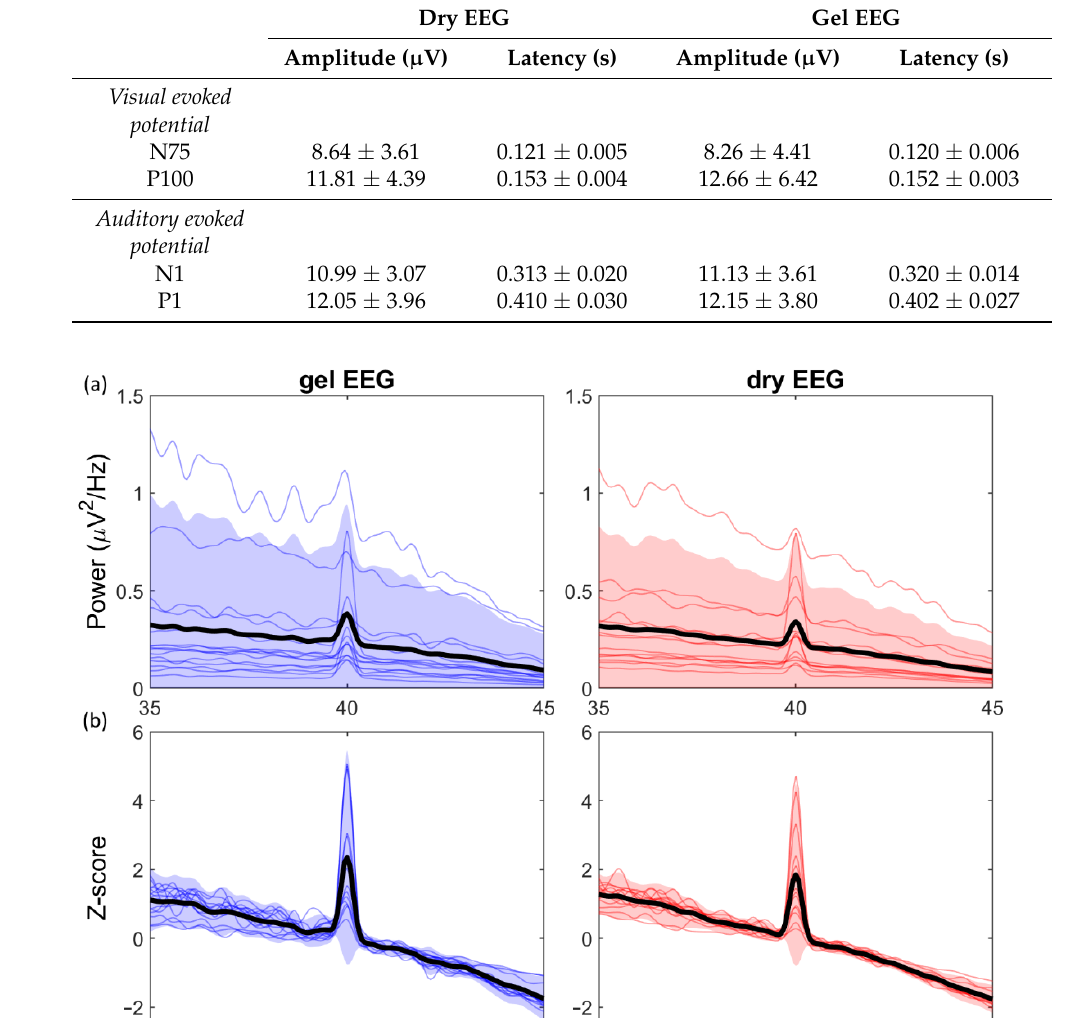
Table 1. The amplitudes ( µ V; mean ± SD) and latencies (s; mean ± SD) of the main components of the visual evoked potential (N75, P100) and the auditory evoked potential (N1, P1), for the dry and the gel EEG system.